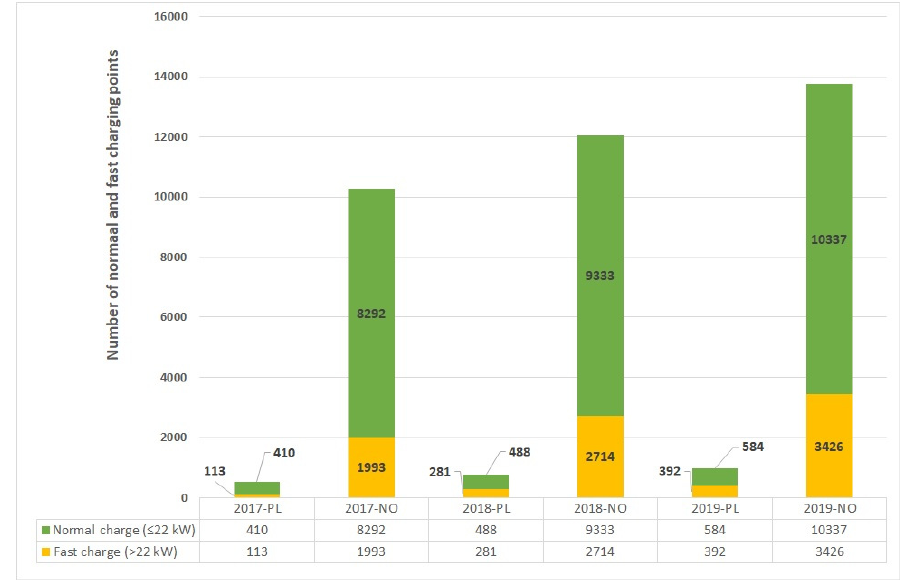
Figure 4. Number of Polish and Norwegian electric car charging points [31] .